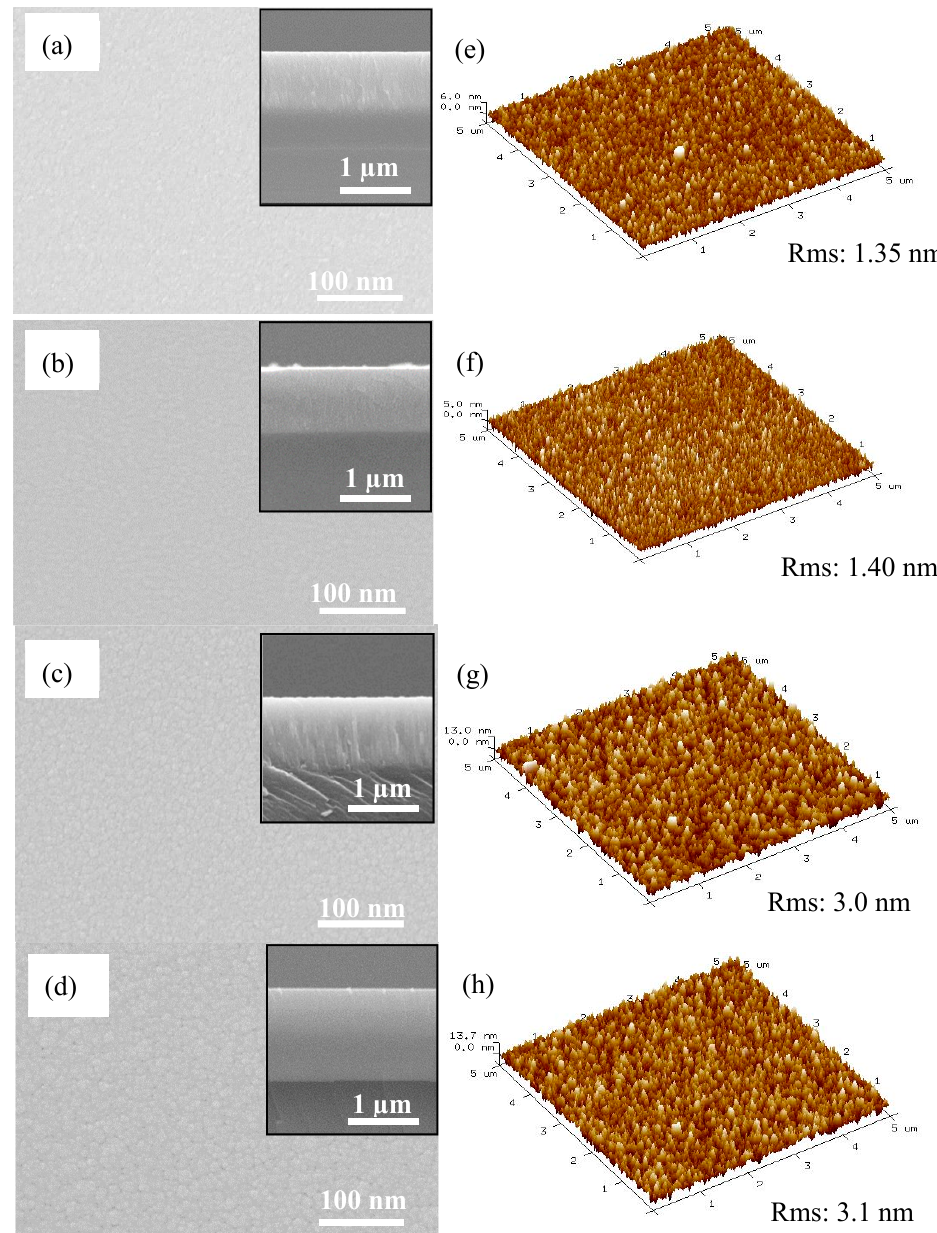
Figure 1. ( a – d ) SEM surface images and ( e – h ) 3D AFM morphologies of Ge 0.07 GaN films at ( a , e ) 100 °C, ( b , f ) 200 °C, ( c , g ) 30 and 400 °C. The insets are their individual cross–sectional images.